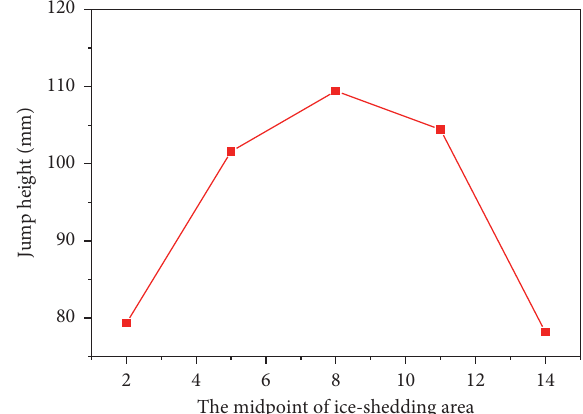
Figure 11: The variation of the jump height with the midpoint of ice-shedding